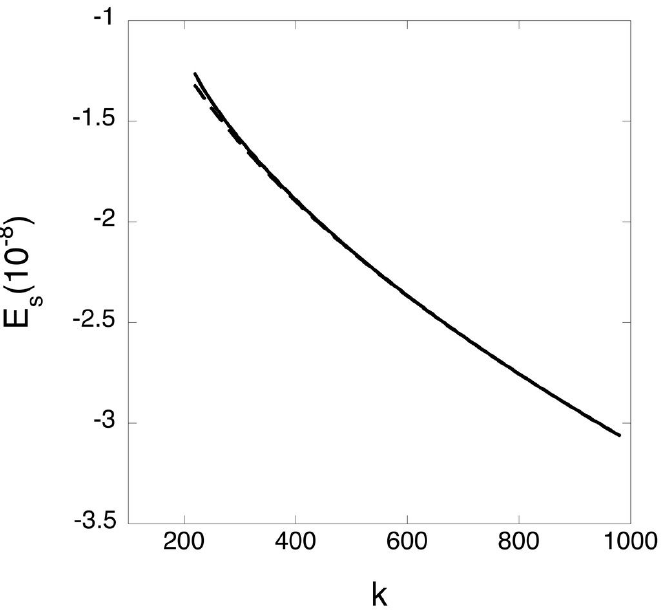
Figure 3. The scaled energy E s = V s,top at the top of the potential barrier versus the scaled pseudomo- mentum k for the scaled magnetic field b = 1.3 × 10 6 (corresponding to B = 5 Tesla). The solid line is the exact result from Equation (34), the dashed line—the asymptotic result from Equation (23).